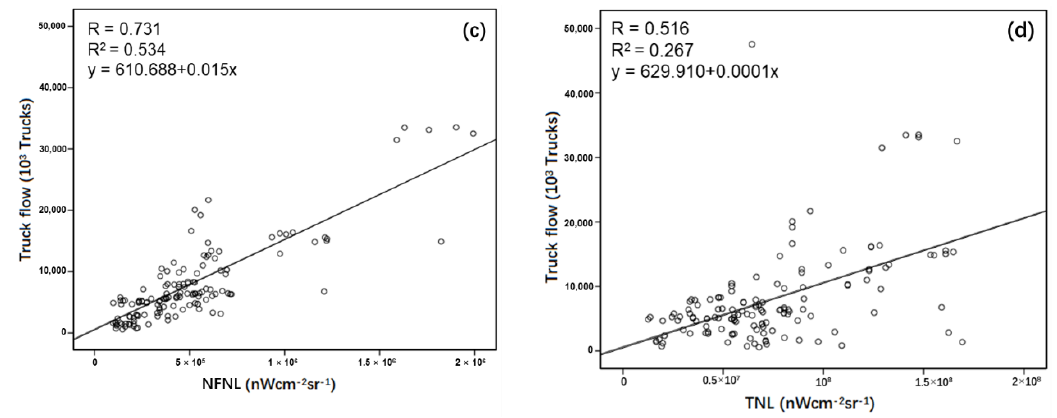
Figure 10. The scatter diagrams for linear regression analysis in provincial units: ( a ) The traffic flow of coach and NFNL, ( b ) The traffic flow of coach and TNL, ( c ) The traffic flow of trunk and NFNL, ( d ) The traffic flow of trunk and TNL.